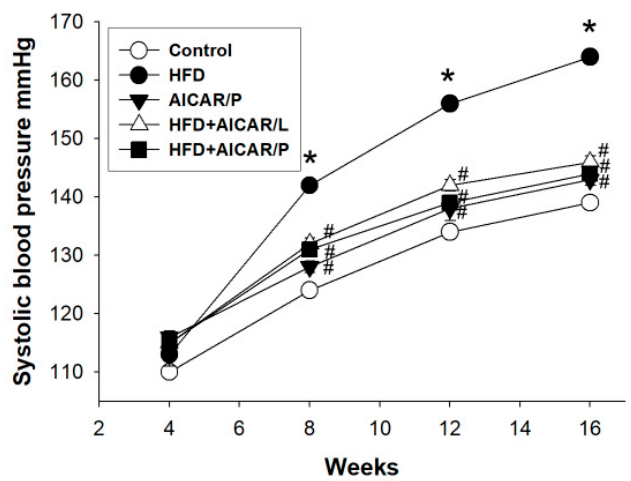
Figure 2. Effect of high-fat diet (HFD) and AICAR treatment in pregnancy (AICAR/P) or lactation Figure 2. E ff ect of high-fat diet (HFD) and AICAR treatment in pregnancy (AICAR / P) or lactation (AICAR/L) on systolic blood pressure in male offspring. * p < 0.05 vs. control, # p < 0.05 vs. HFD. (AICAR / L) on systolic blood pressure in male o ff spring. * p < 0.05 vs. control, # p < 0.05 vs. HFD.